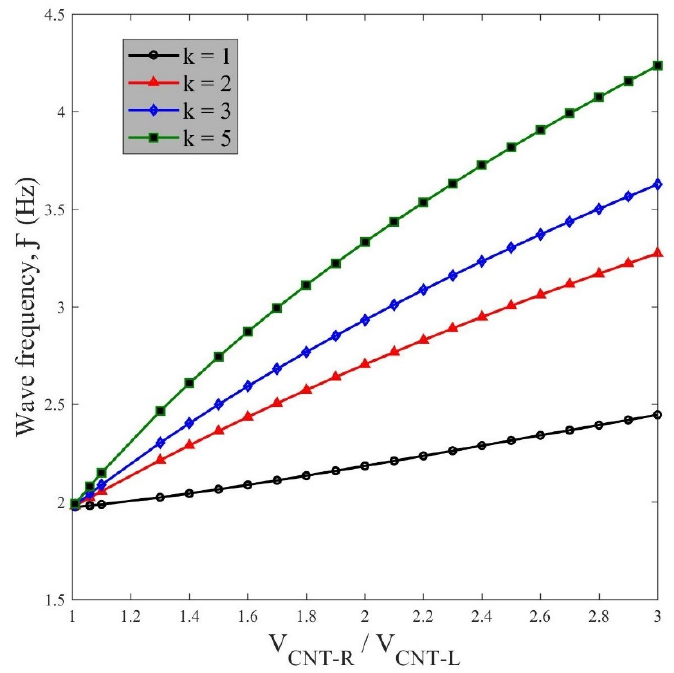
Figure 10. Wave frequency vs. the rational value V CNT − R / V CNT − L for different k .